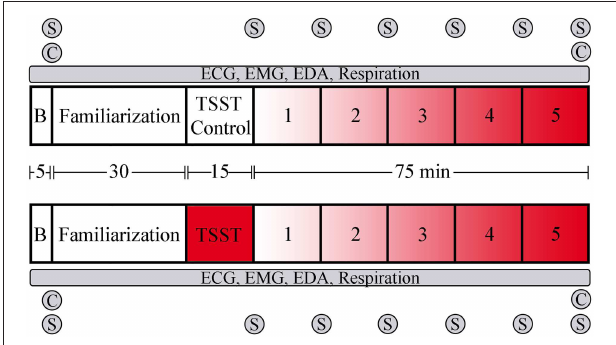
FIGURE 1 | Overview and timeline of the experimental design. The upper portion represents the control group that did not receive socioevaluative stress prior to scenario performance, while the lower portion represents the group that received the TSST. Following baseline physiological recording and training in the virtual environment, participants went through the TSST or control task. Task presentation followed immediately, with task order counter-balanced via a Latin squares method. B, baseline period; C, saliva sample for cortisol measurement; S, STAI administration. Red shading indicates level of stressor